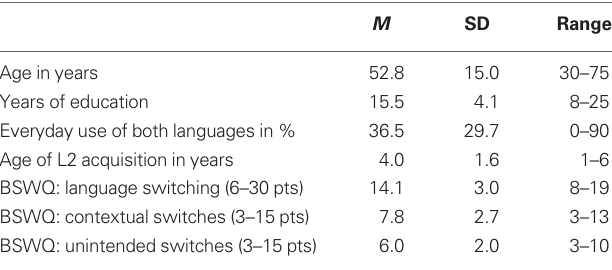
Table 1 | Demographics and scores on the BSWQ subscales.